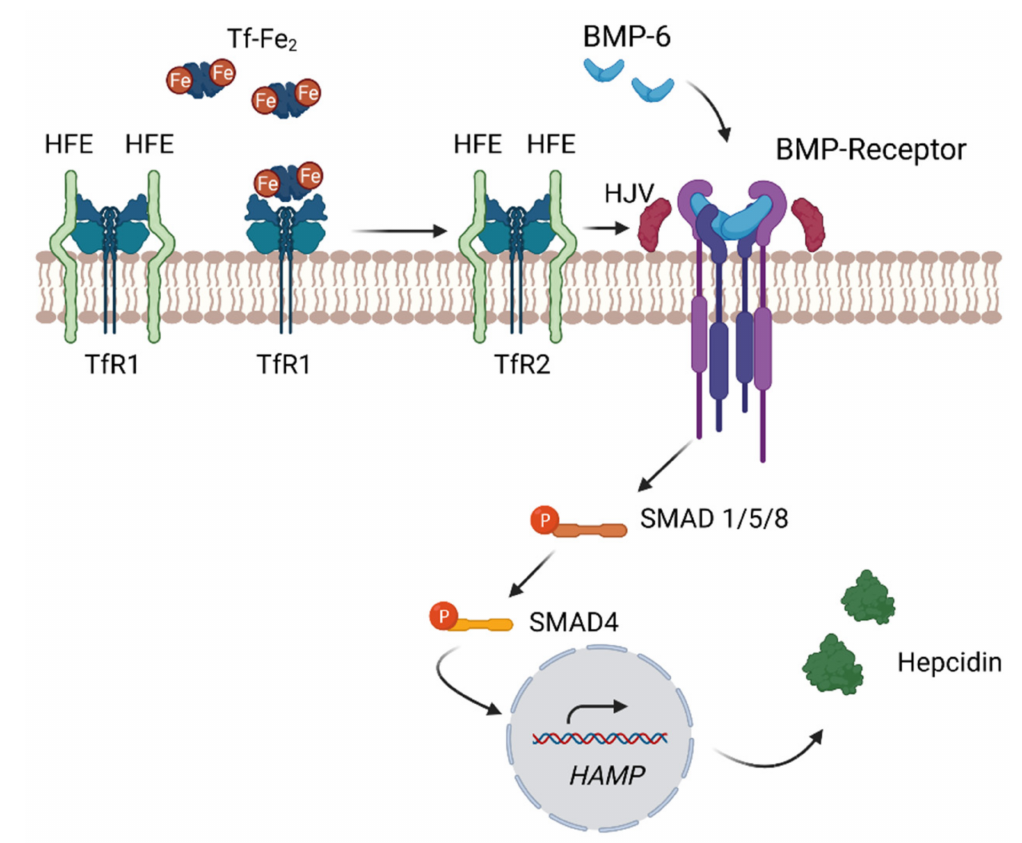
Figure 3. Regulation of Hepcidin Expression. Circulating hepcidin regulates the amount of iron released into the blood from macrophages and especially hepatocytes. Decreased hepcidin expression occurs when the rate of erythropoiesis increases (e.g., in response to anemia), leading to increased ferroportin expression causing increased iron transfer into blood. In contrast, hepcidin expression is increased by elevated plasma iron (Tf-Fe 2 ) or inflammation to counteract an oversaturation of Tf or iron loss, preventing the formation of cytotoxic NTBI. The liver directly senses circulating iron bound to Tf or indirectly in response to iron-induced BMP6. Increased hepatic iron levels induce the expression of BMP6. BMP6 stimulates hepcidin expression by binding to the BMP receptor and HJV, leading to intracellular signaling via SMAD proteins, coupled with SMAD4 translocating to the nucleus and inducing hepcidin expression. The liver directly senses circulating iron by expression of TfR1 and TfR2. With increasing serum iron levels, Tf-Fe 2 binds to TfR1 and HFE binding to TfR2 is induced. This complex interacts with HJV and enhances the BMP signaling pathway, leading to hepcidin transcription. The illustration was created using BioRender.com, (accessed on 22 April